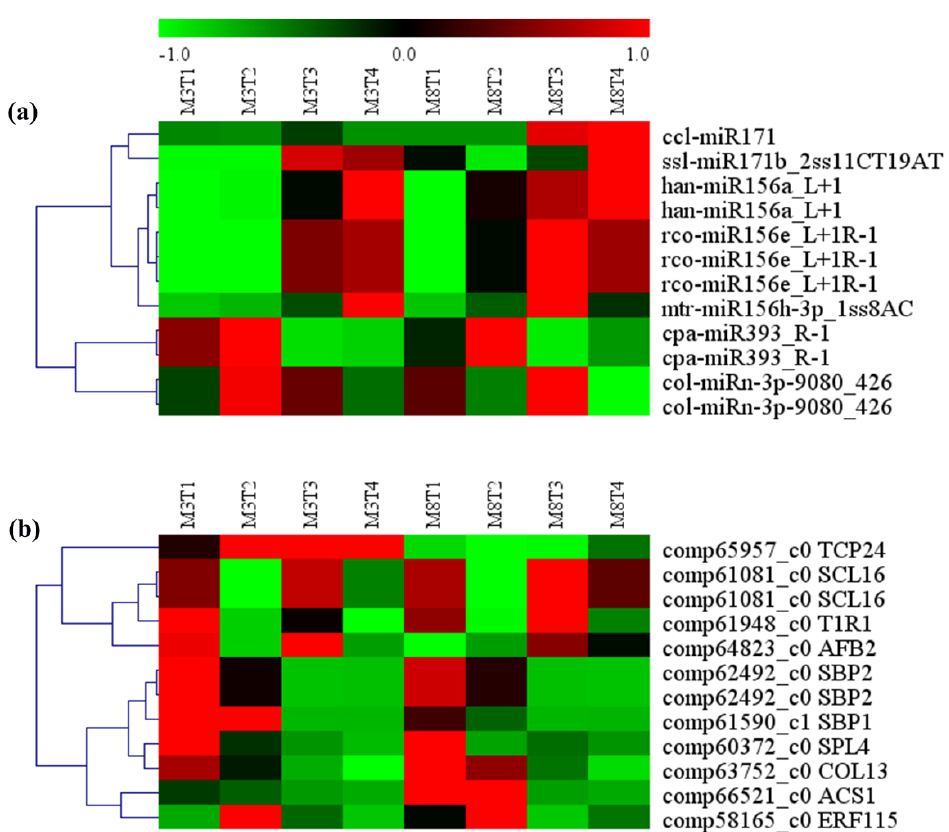
Figure 10. Heat map analysis of ( a ) predicted differentially expressed miRNAs, and ( b ) their target genes, involved in the growth and development of seeds from the ‘M3’ and ‘M8’ cultivars at four developmental stages. Red and green colors indicate high levels and low levels, respectively, of the miRNAs and their targets.